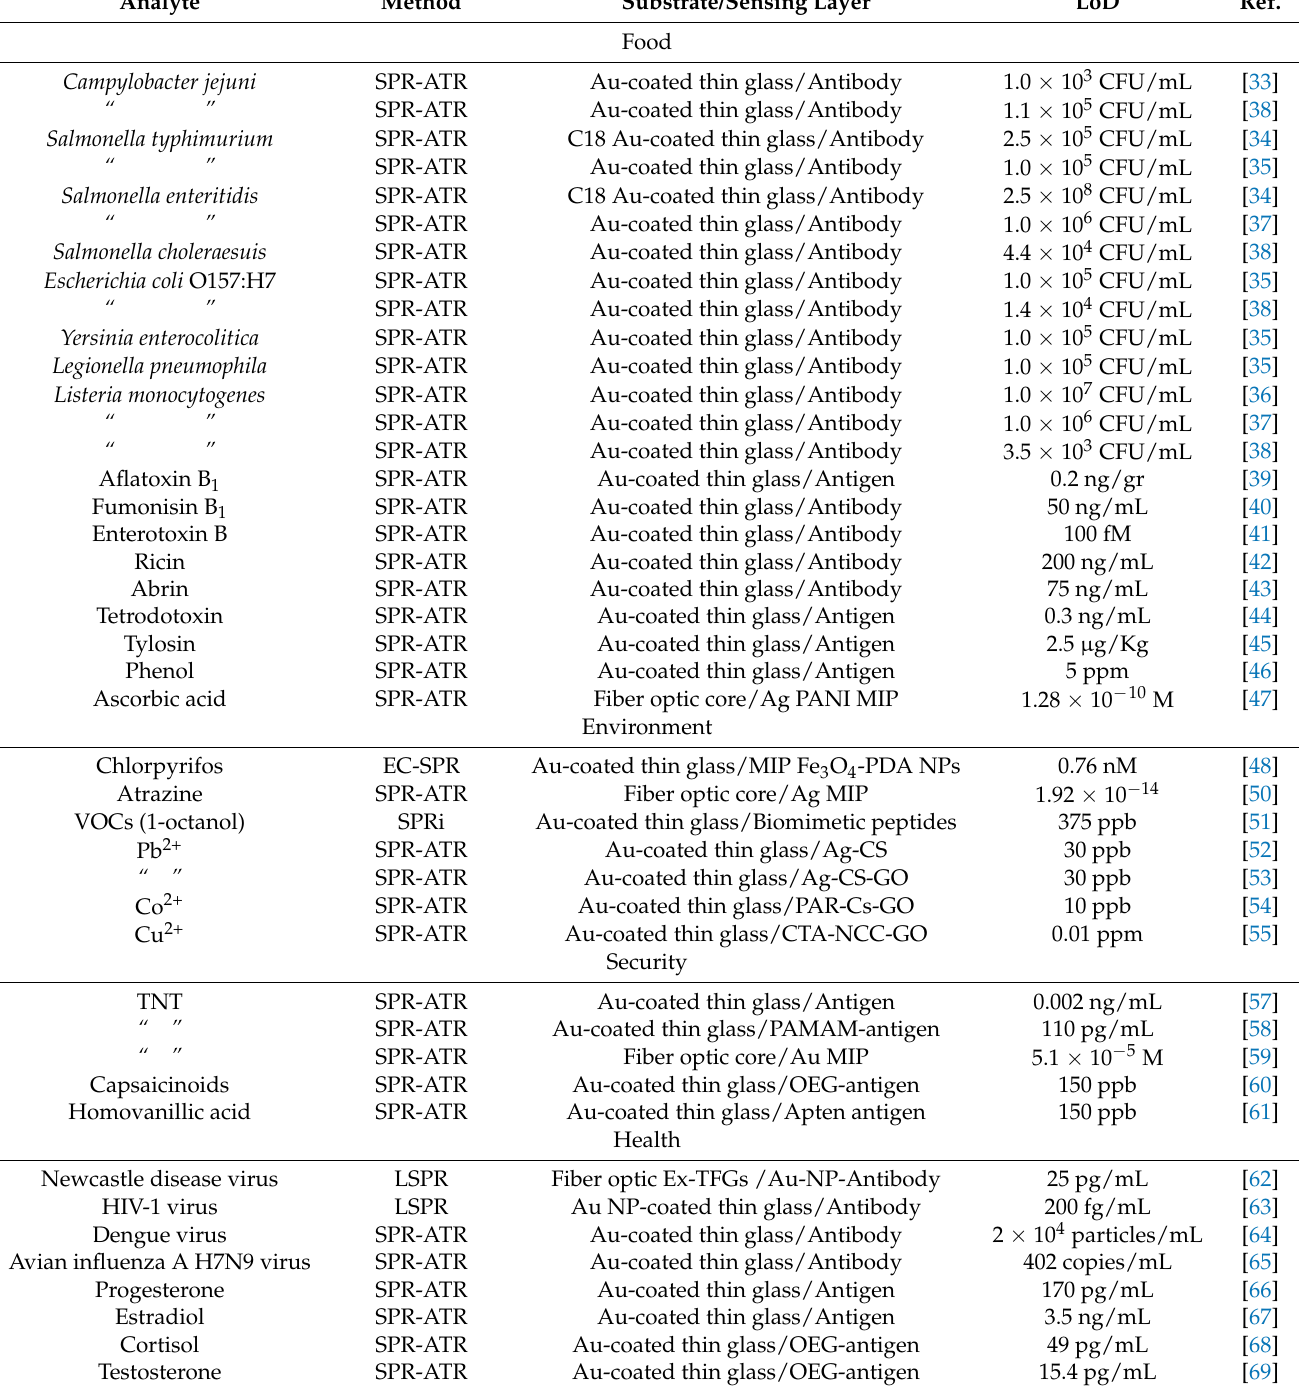
Table 1. List of analyte targets detected by surface plasmon resonance (SPR)-based